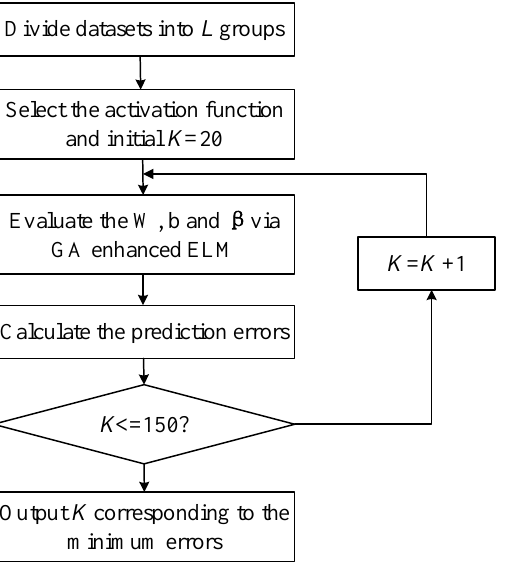
Figure 5. Flowchart of determining proper neuron number K in the hidden layer.